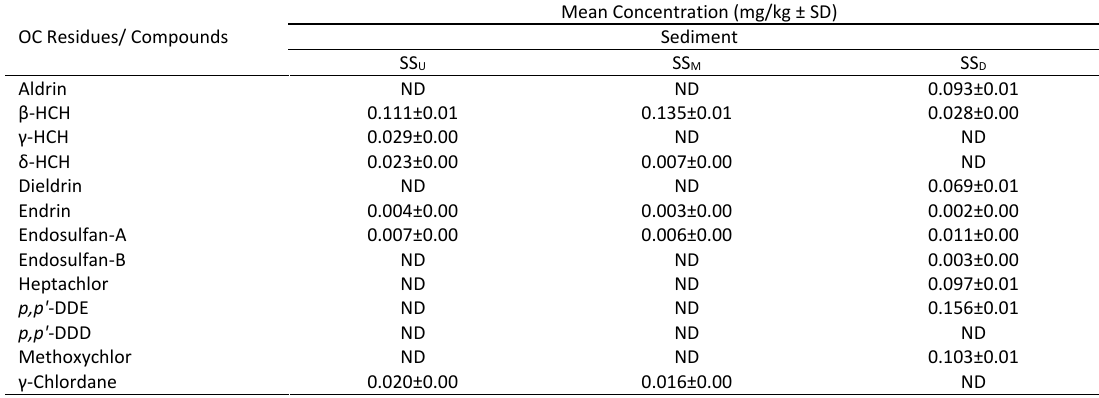
Table 2: Mean concentrations of OC residues in sediment across sampling zones OC Residues/ Compounds